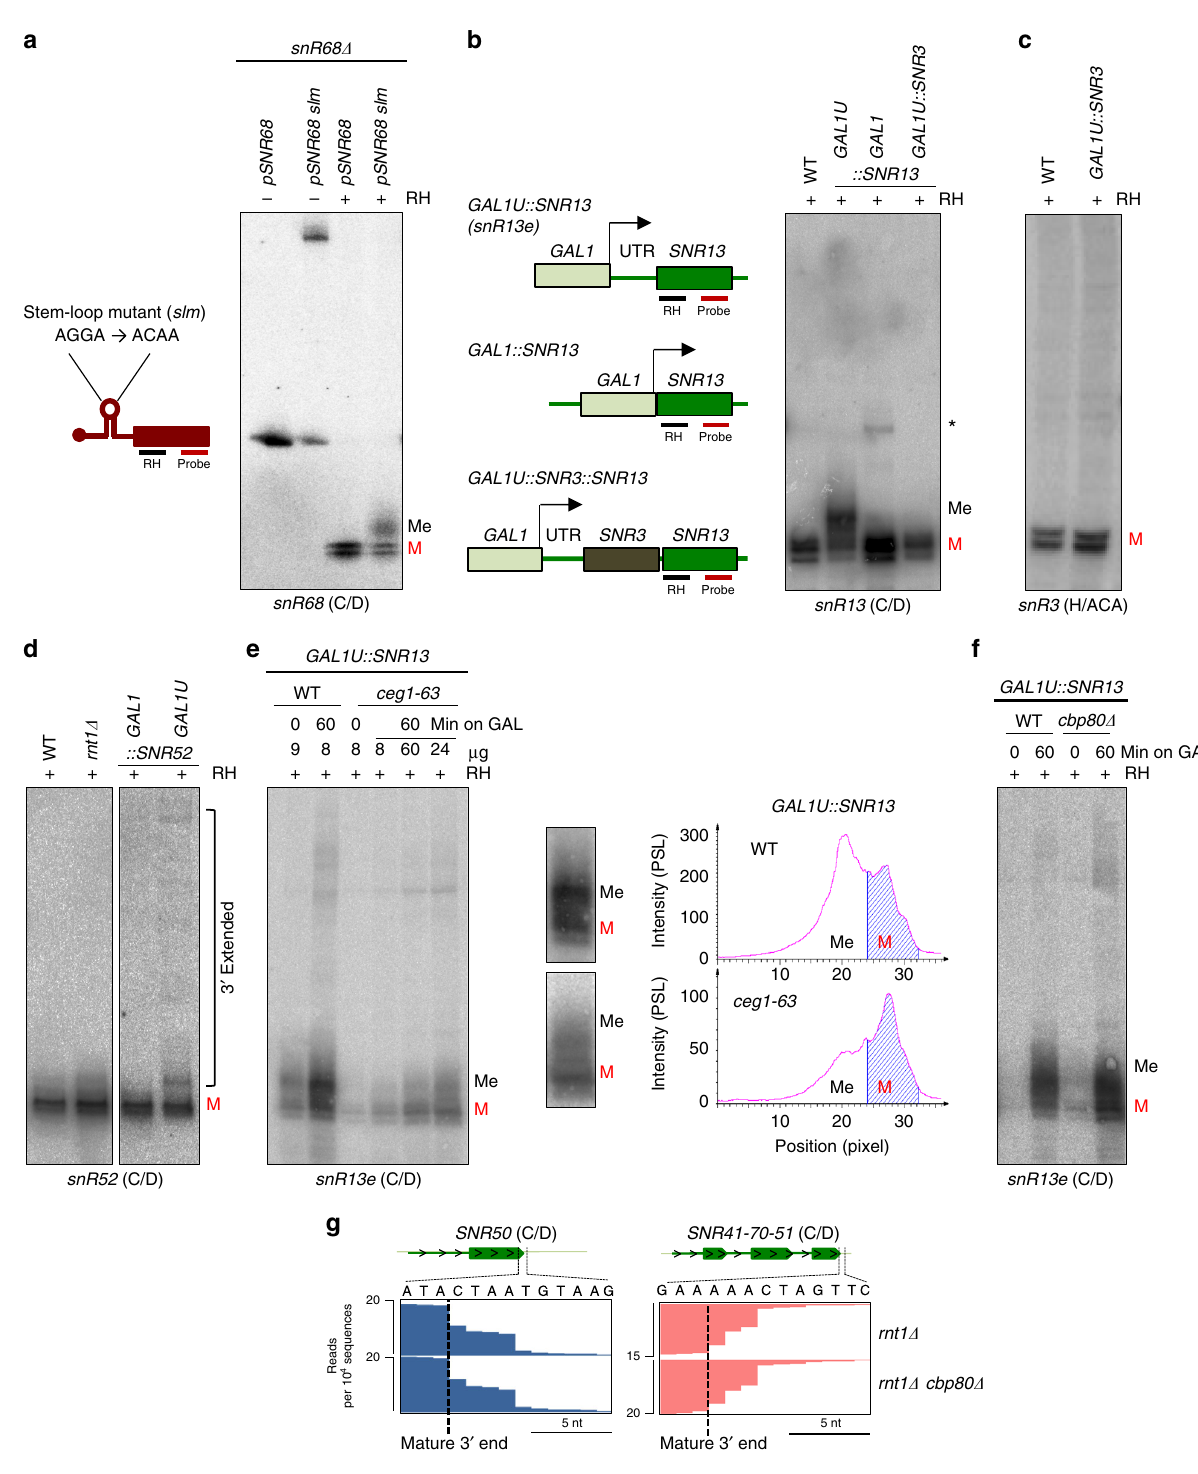
Fig. 4 Capped 5 ʹ extension affects box C/D pre-snoRNA 3 ʹ end processing. a Northern blot of WT snR68 or mutated in the stem-loop. Oligonucleotides used for RNase H cleavage and detection are indicated on the left. b Northern blot of SNR13 modi fi ed strains. Diagram on the left shows variants of endogenous SNR13 expressed from ectopic GAL1 promoter and oligonucleotides used for RNase H cleavage and detection. Asterisk marks incompletely digested snR13. c Northern blot analysis of SNR3 expressed from GAL1 promoter. d Northern blot analysis of snR52 transcribed from endogenous (Pol III- dependent) and GAL1 promoter in rnt1 Δ and WT strains. e Northern blot and quantitation of snR13e transcripts in ceg1-63 strain. Amount of RNA loaded on the gel is indicated above the radiogram. Blue stripes on the hybridization pro fi les indicate the area covering 3 ʹ processed snR13e. f Northern blot of snR13e expressed in cbp80 Δ strain. g RNA-seq showing snoRNA 3 ʹ ends in rnt1 Δ cbp80 Δ strain. a – f RNA was treated with RNAse H to create homogenous 5 ʹ ends. M denotes snoRNA with mature 3 ʹ ends; Me denotes snoRNA with 3 ʹ end